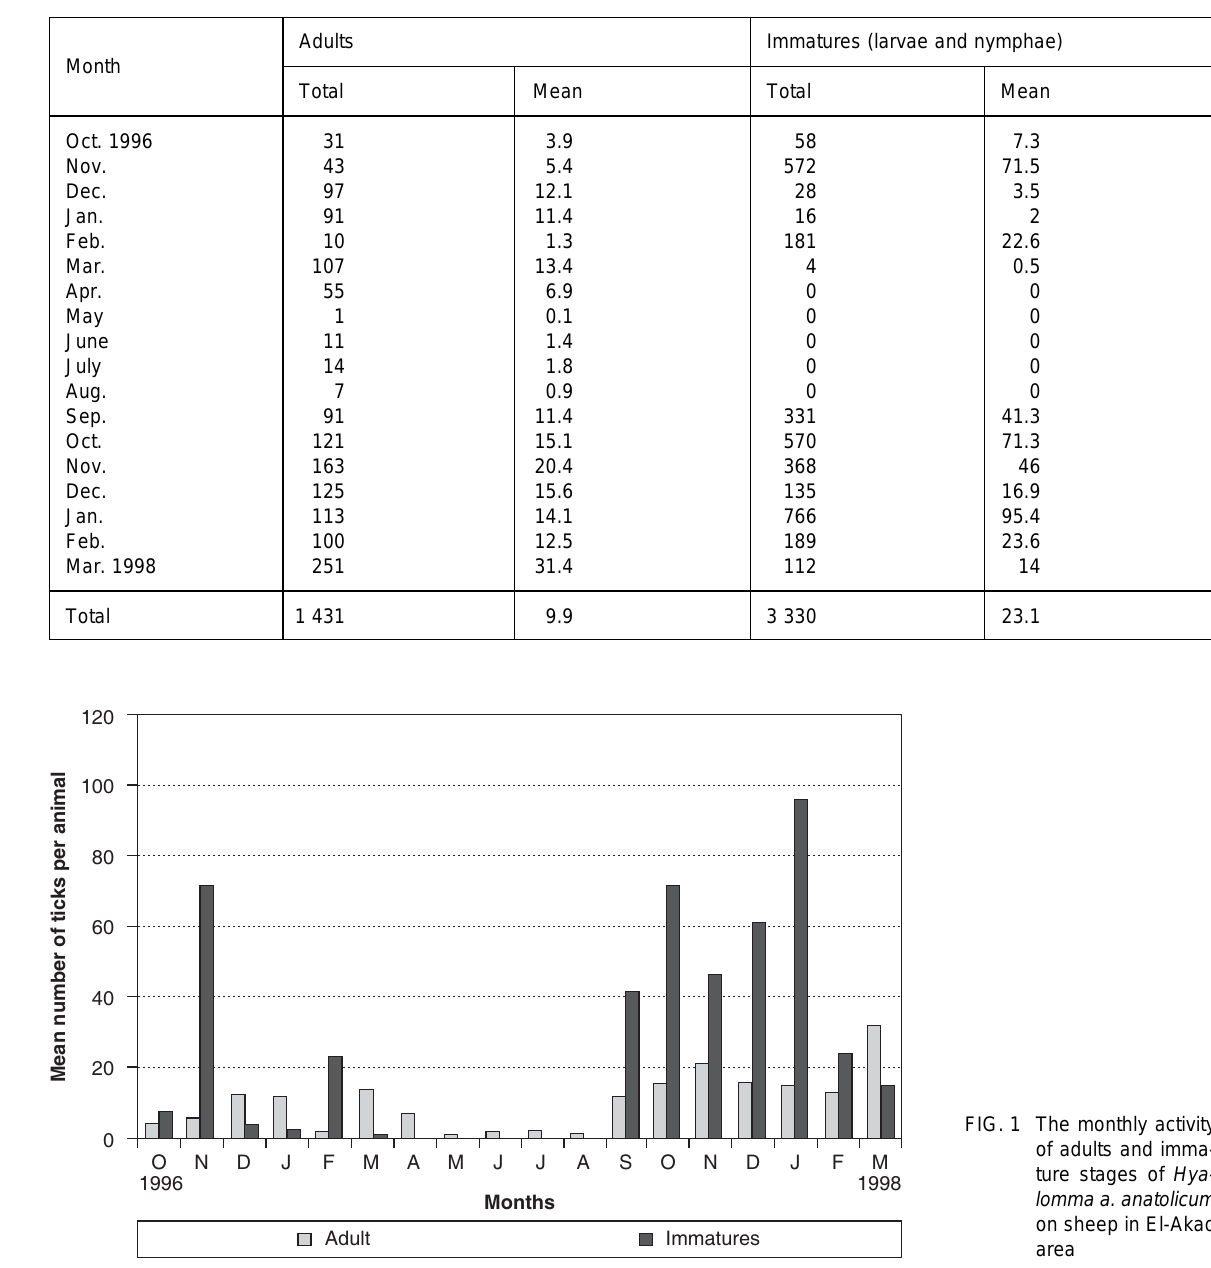
TABLE 2 Monthly variations of H. a. anatolicum found on sheep at El-Akad area